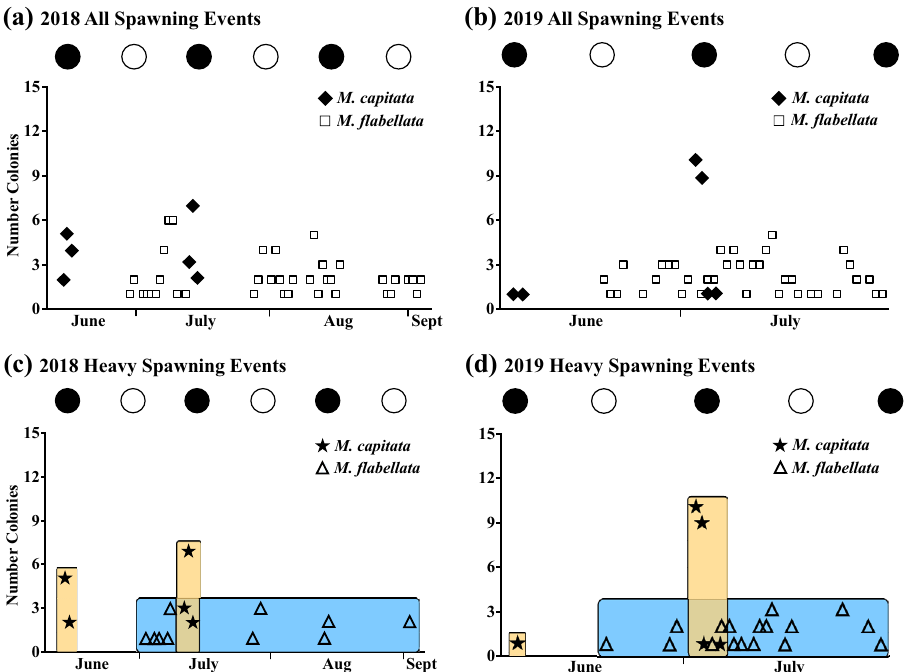
Figure 3. Number of spawning colonies observed per night, 2018 and 2019. All spawning events (light and heavy spawns) with number of colonies spawning per night in ( a ) 2018 and ( b ) 2019 [ M. capitata (n = 10, 2018; n = 16, 2019) and M . flabellata (n = 16, 2018; n = 14, 2019)]. ( c ) Total number of colonies per night that only heavily spawned in 2018 and ( d ) 2019. In contrast to M. capitata , there were relatively few (at most three) colonies of M . flabellata that heavily spawned on any given night. Throughout both summers M. capitata exhibited large episodic spawning events within a narrow window of a few days in June and July corresponding with the new moon, which is common for the species. By contrast, M . flabellata showed smaller distributed spawning events with intermittent heavy spawning, low number of colonies spawning per night, and without an apparent lunar cycle cue. Filled circles are new moon; empty circles ◯ are full